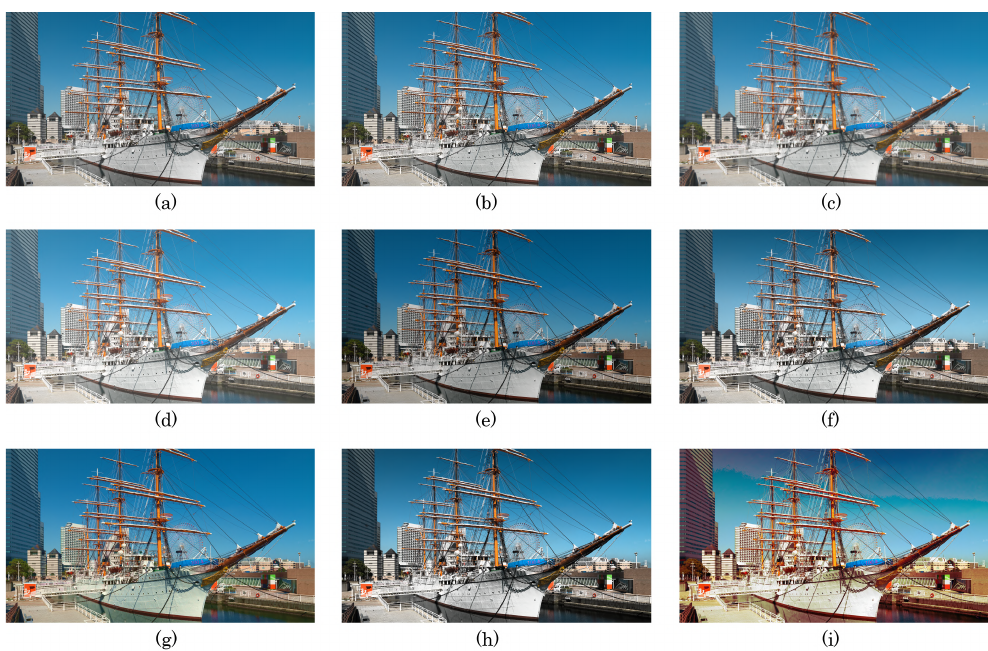
Figure 6. Raw image and output images through proposed and previous methods [1,12] (Ship).